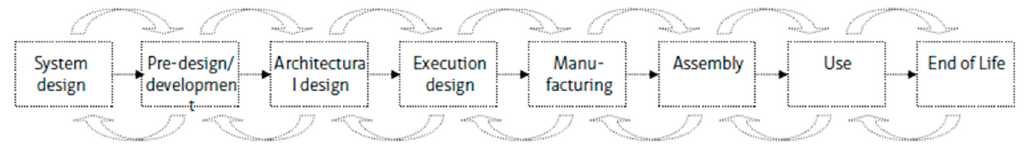
Figure 2. Phases in a typical construction project (Behera et al. [14]; reprinted with permission: Taylor and Francis).